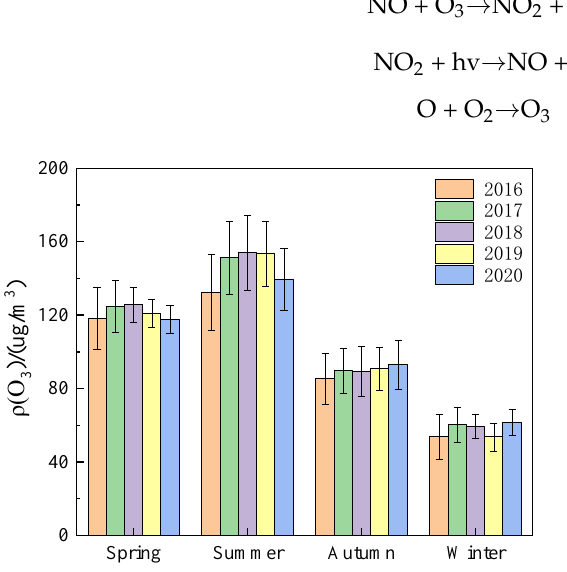
Figure 2. Seasonal changes in O 3 concentrations in the NCP from 2016 to 2020.